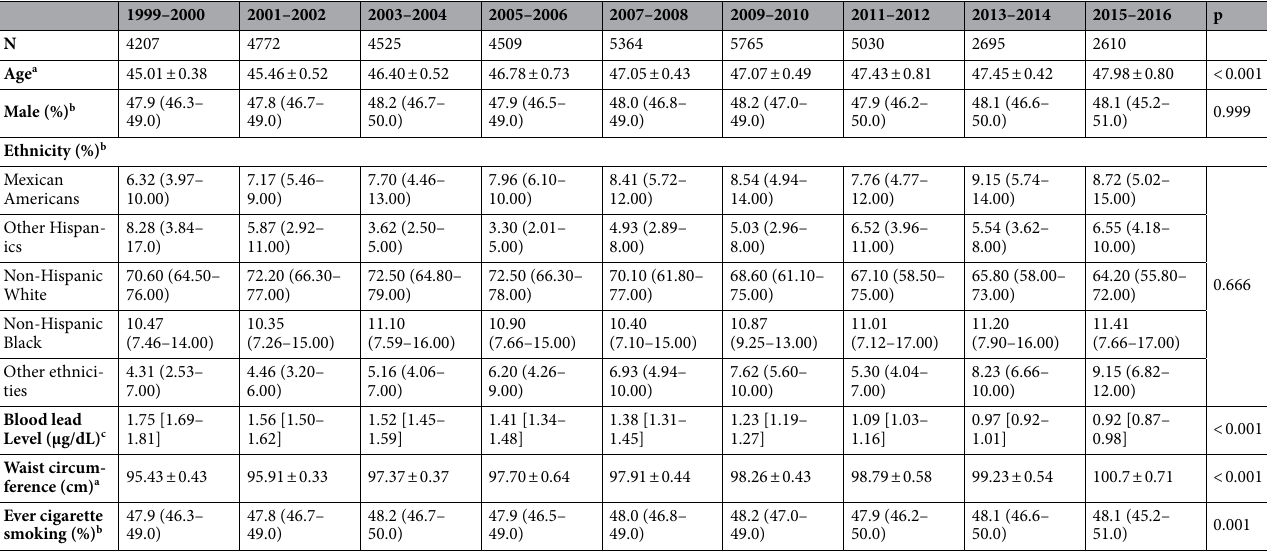
Table 1. Characteristics of participants included in this study. a Figures are expressed as mean ± standard error (for mean age and waist circumference). b Figures are expressed as percent (95% confidence intervals) (for gender, ethnicity and ever cigarette smoking). c Figures are expressed as mean blood lead levels (95% confidence intervals).